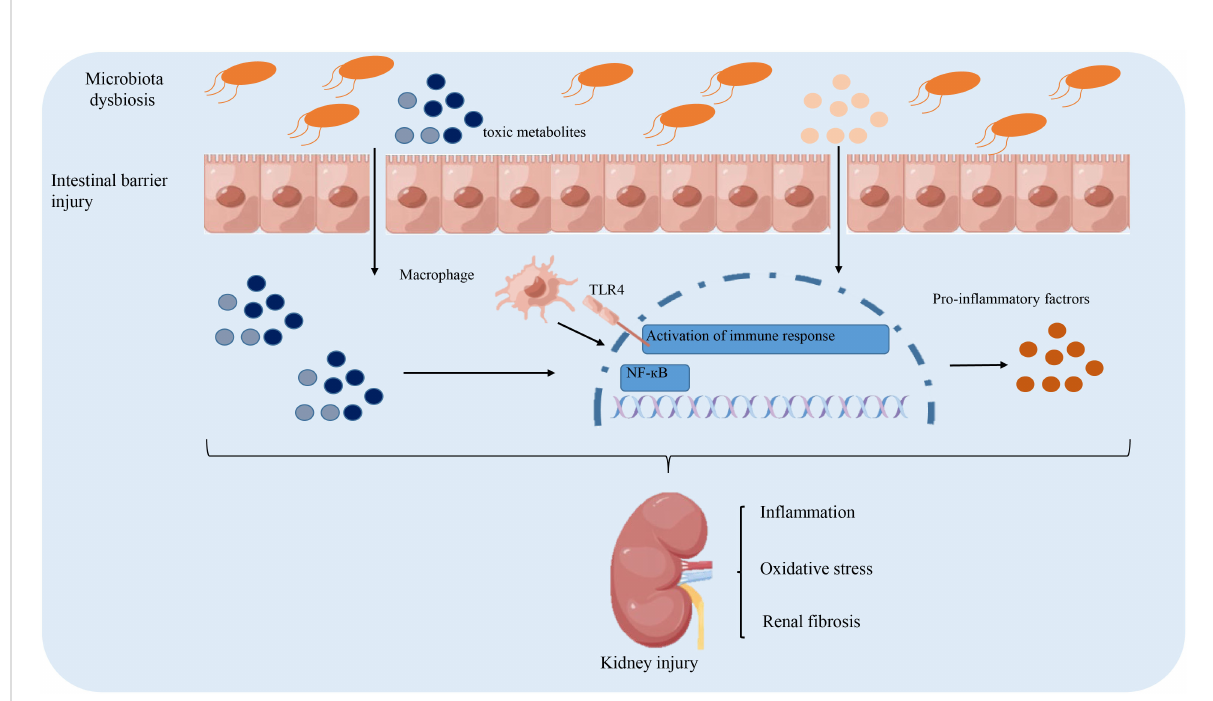
FIGURE 1 The role of gut microbiota dysbiosis implicated in the pathogenesis of diabetic kidney disease. Intestinal dysbiosis results in the accumulation of toxic metabolites, which damage the integrity of the intestinal barrier to facilitate the in fl ux of toxic metabolites into the circulation. This triggers an immune response to secrete pro-in fl ammatory cytokines that contribute to renal fi brosis and oxidative stress. Altogether, these pathological factors lead to the accelerated progression of